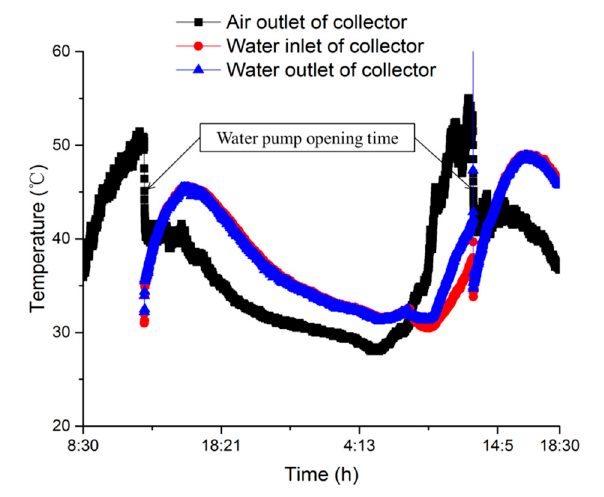
Figure 17. The variation of DF-FPSC air and water outlet temperature.